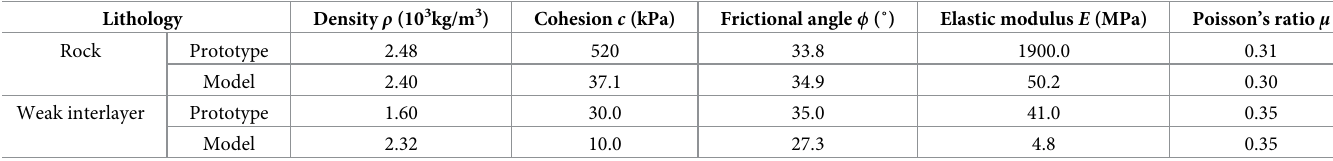
Table 3. Physical and mechanical properties of prototype slopes and model